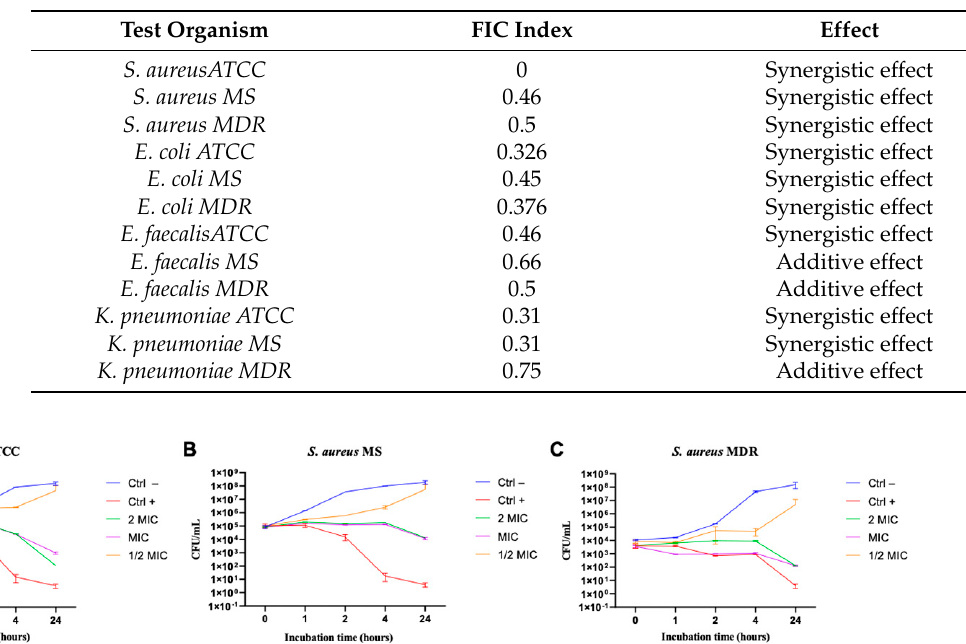
Table 6. Interpretation of checkerboard assay.